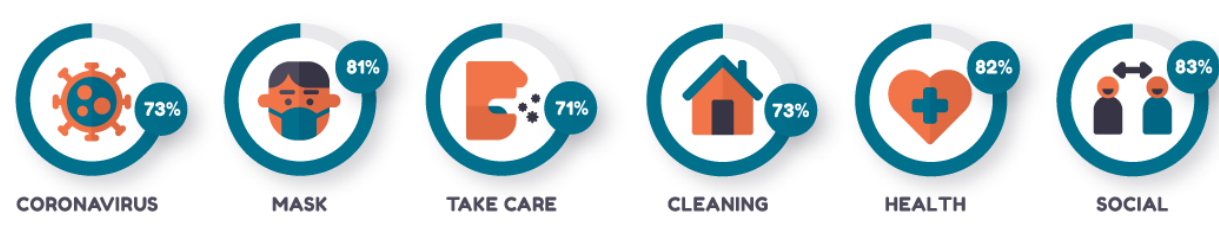
Figure 9. Correct answer rate for each game topic between July 20 and September 13, 2020.